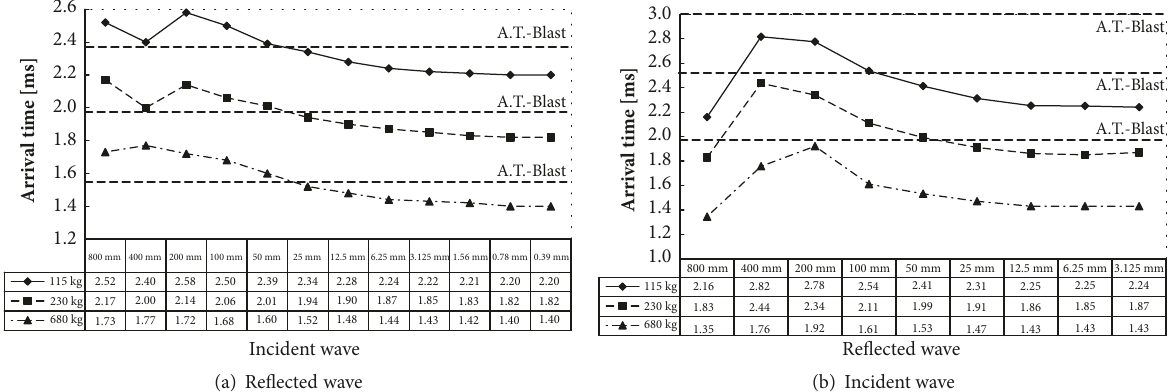
Figure 7: Blast wave time of arrival for different air mesh